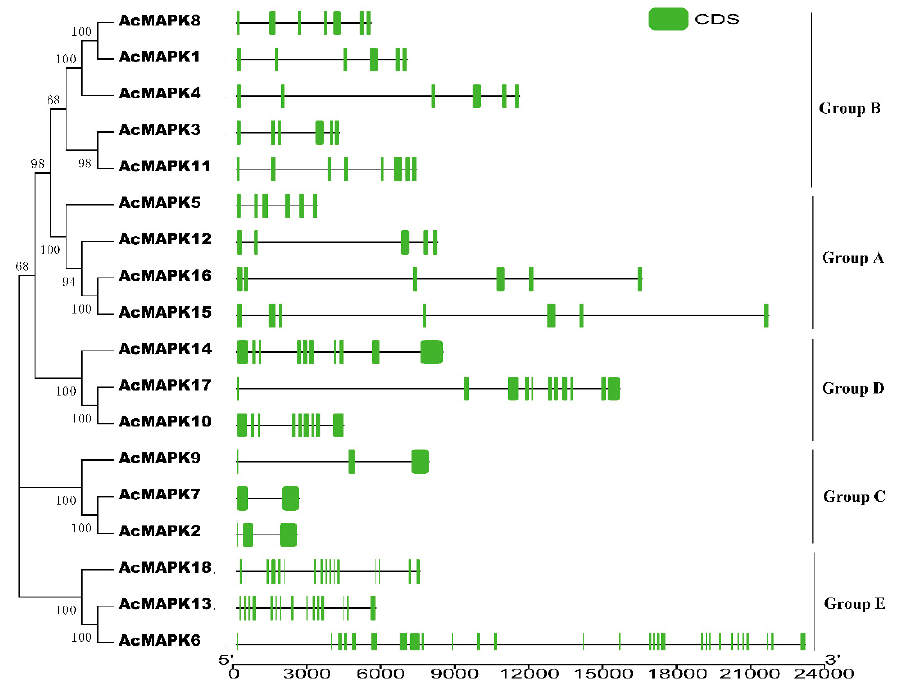
Figure 2. The phylogenetic analysis and intron/exon structures of putative MAPK genes in A. chinensis . The phylogenetic tree (left panel) was created using MEGA5.0 program with the neighbor-joining (NJ) method. Exon/intron structures of the MAPK genes are shown in the right panel. The green boxes indicate the exons, whereas the single lines indicate introns. Gene models were drawn to scale as indicated on bottom.